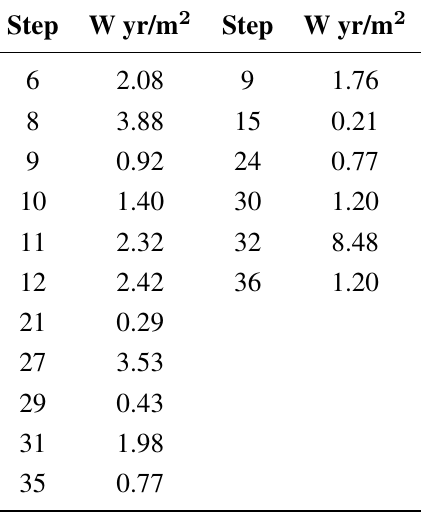
Table 9. Two volcanic radiative forcing